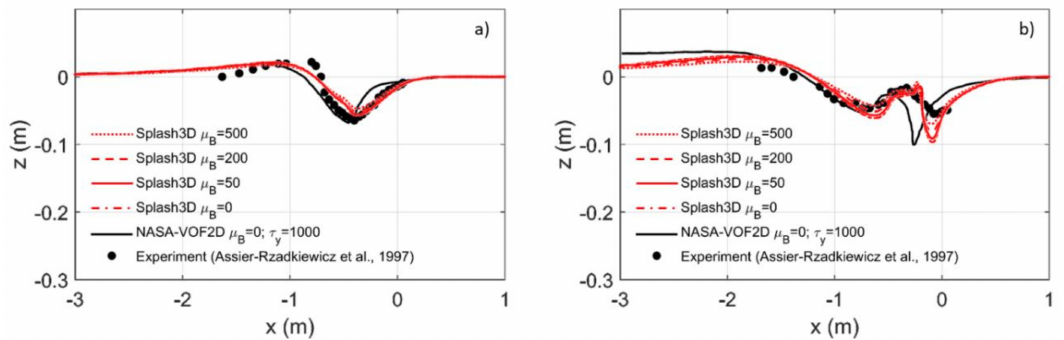
Figure 7. The comparison of free-surface profiles for di ff erent yield viscosity µ B in the Bingham model. Di ff erent lines indicate di ff erent values of µ B . The dots represent the experimental results from Assier Rzadkiewicz at: ( a ) t = 0.4 s and ( b ) t = 0.8